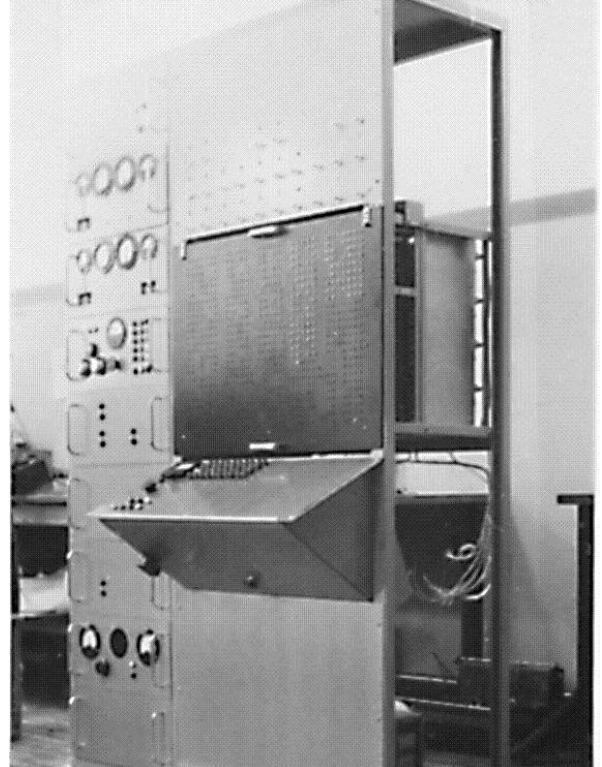
Figure 1: The analog computer DIANA developed in Trondheim for solution of differential equa- tions and control of processes and